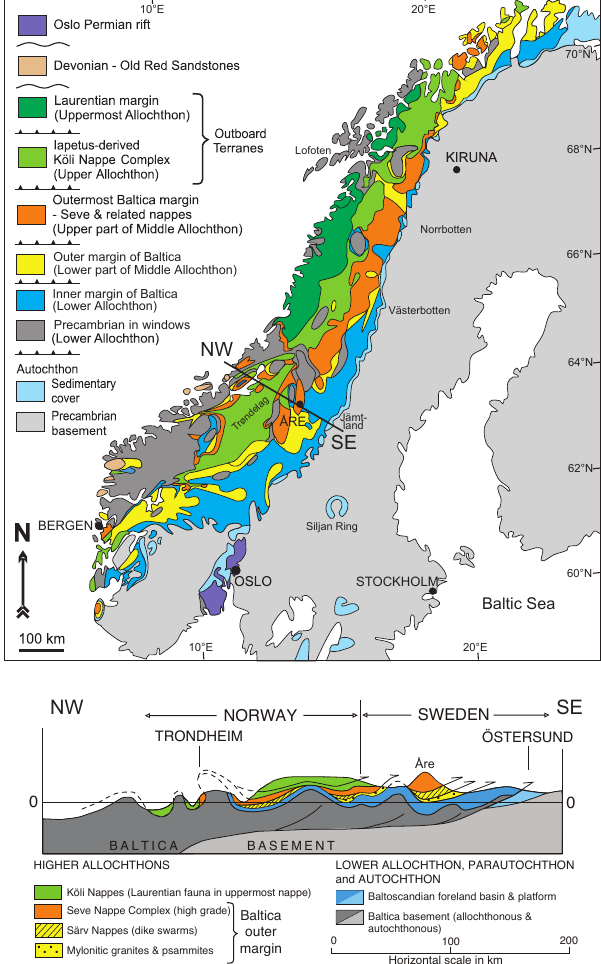
Figure 2. Tectonostratigraphic map of the Scandinavian Cale- donides and sketch section along the geotraverse from Östersund to the Norwegian coast. Modified from Gee et al.